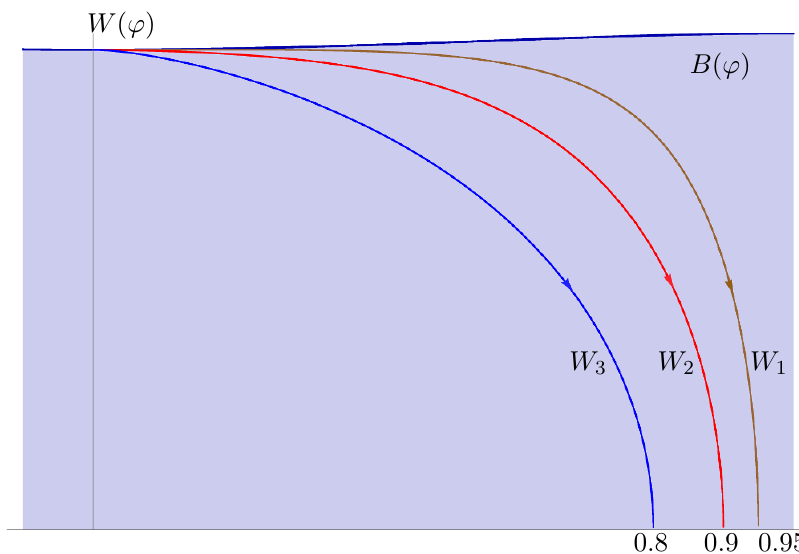
Figure 14. Solutions for W ( ’ ) with R < 0 and for the potential (5.1) with (cid:1) (cid:0) = 1 : 2. The three solutions W i ( ’ ) with i = 1 ; 2 ; 3 have di(cid:11)erent IR turning points ’ 0 . For negative curvature case, the superpotential W ( ’ ) can go into the area below the critical curve B ( ’ ) = the shaded